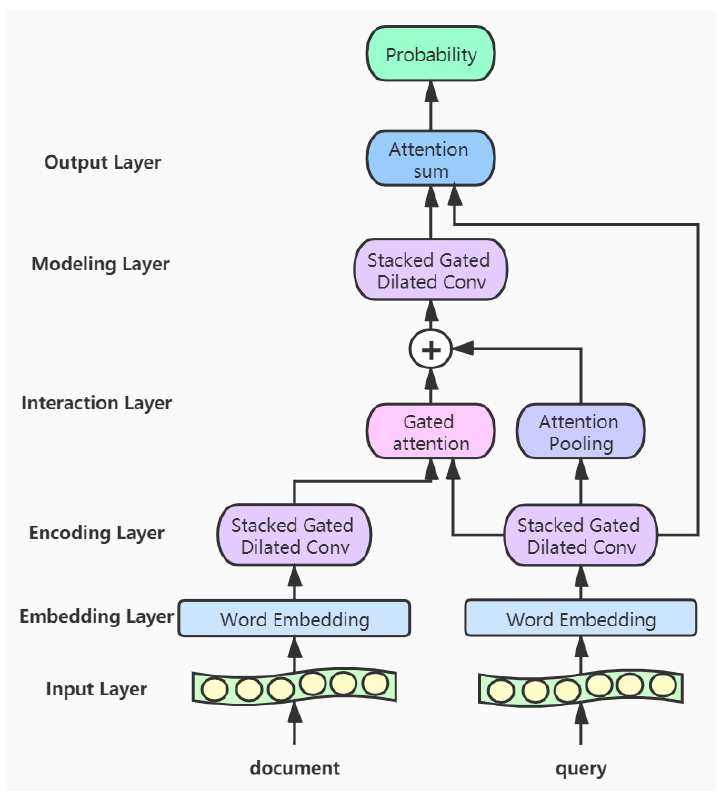
Figure 2. The architecture of Gated Dilated Convolution with Attention model.